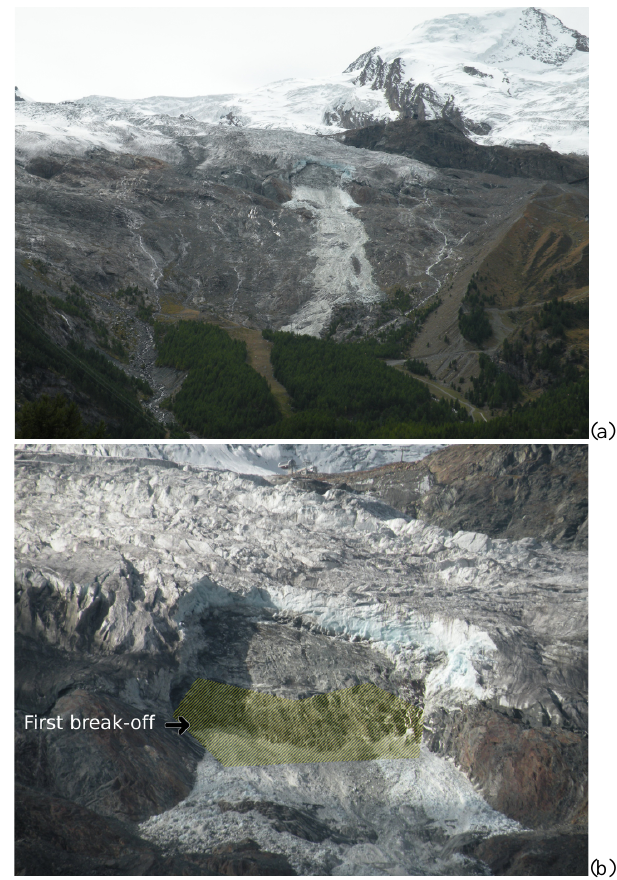
Fig. 17. (a) General view of the Feegletscher after the break-off event in 2009. (b) Closer view of the break-off. Yellow zone in- dicates the extension of the first break-off event (Photo Archive